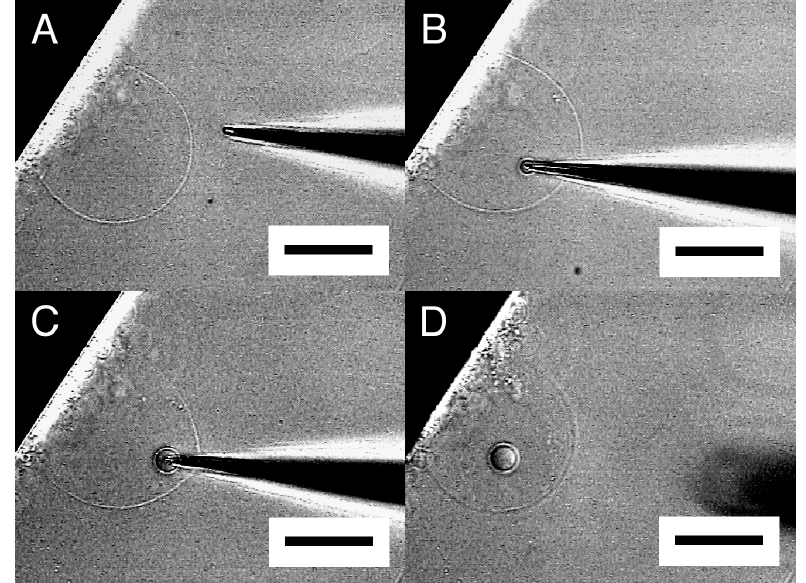
Figure 3. Formation of an inner GV in semi-spherical membrane. Images are the membrane before micromanipulation ( A ), with a microneedle inserted ( B ), with bleeding Ficoll solution from the needle ( C ), and with an inner GV encapsulating the Ficoll left after pulling out the needle ( D ). Bar = 50 μ m.